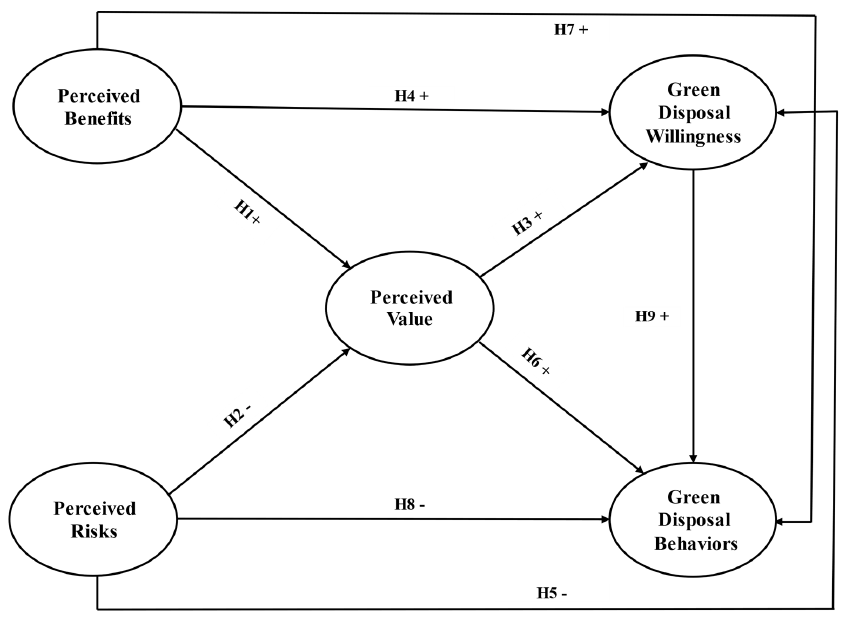
Figure 1. Theoretical Model.